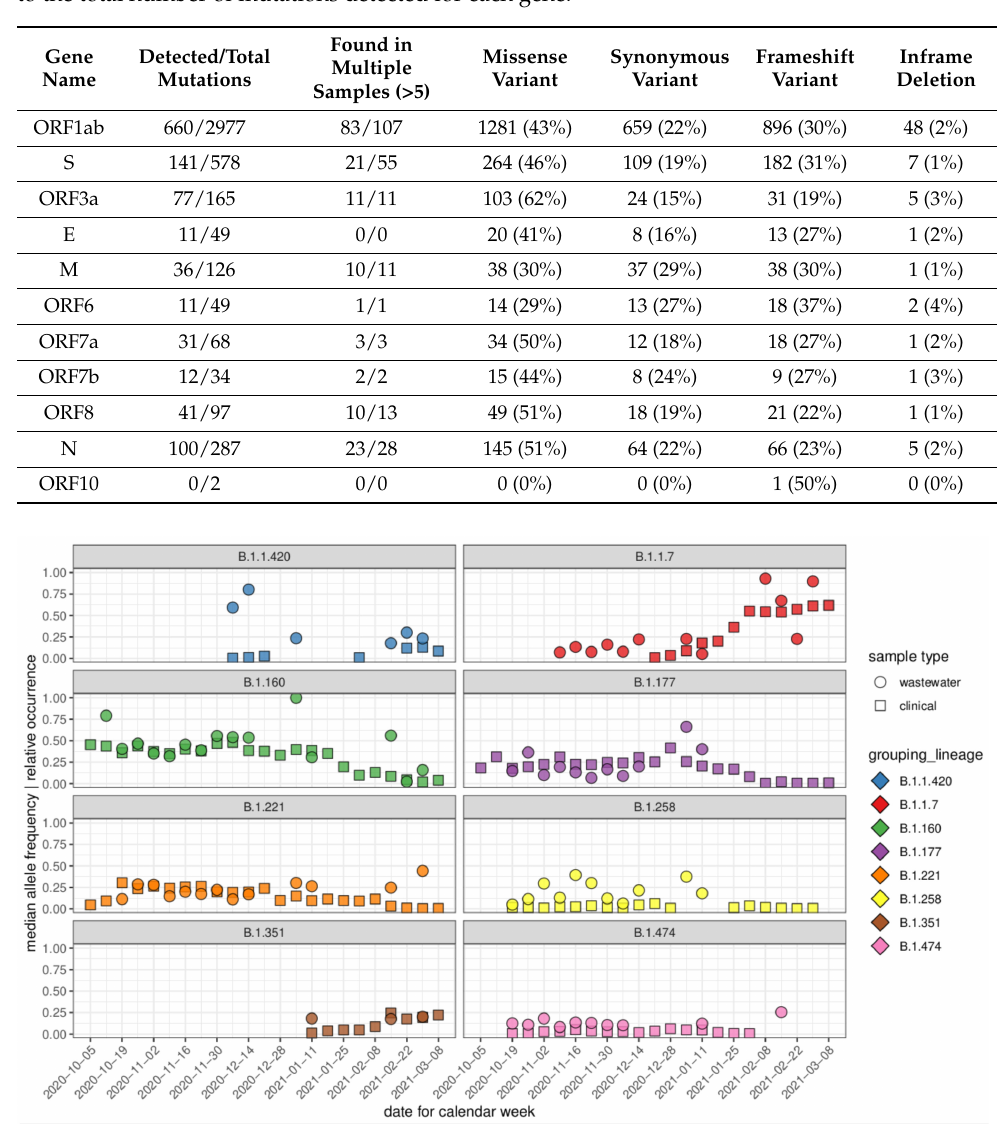
Figure 2. Comparison of median allele frequencies of signature mutations in wastewater samples (circles) to relative occurrence of lineages in clinical samples (squares) after 1 October 2020. Lineages with at least 3 signature mutations and at least 80 associated clinical samples are shown. Samples are grouped per calendar week, and each point represents at least 1 signature mutation detected in 1